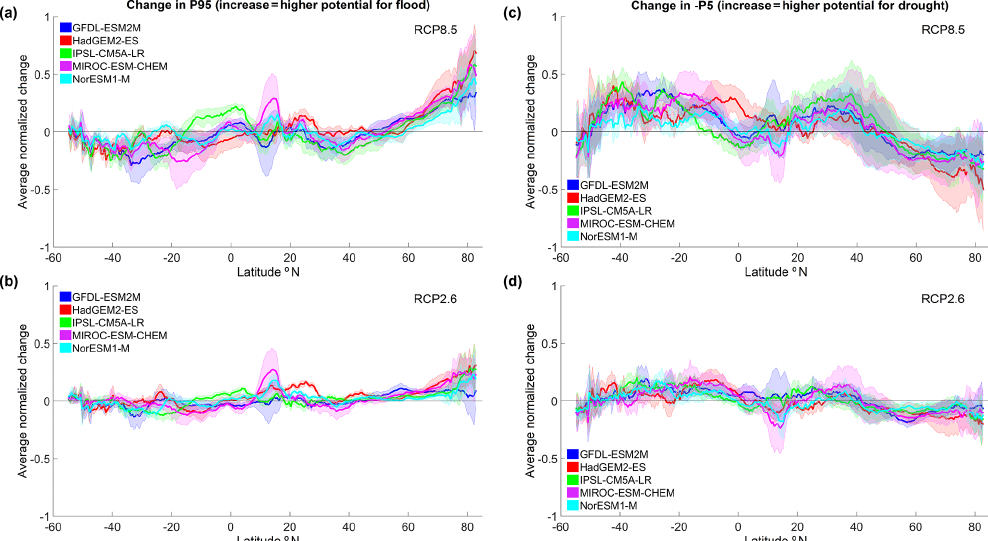
Figure 4. Multi-model change in P95 under the RCP8.5 (a) and RCP2.6 scenarios (b) , and change in P5*–1 under the RCP8.5 (c) and RCP2.6 scenarios (d) , averaged by latitude. The thick lines in the plots show the mean change in the indicator, based on the streamflow from each GCM’s simulated climate routed by multiple GHMs, and the shading denotes ± 1